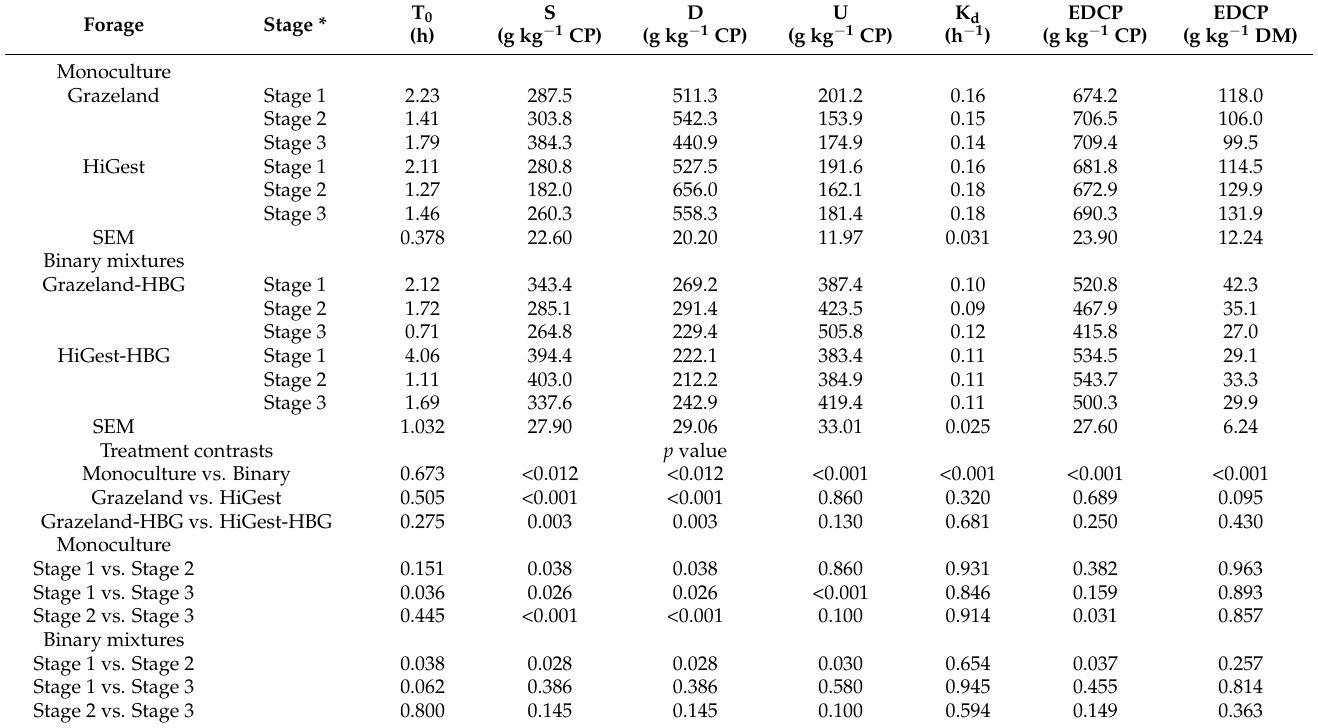
Table 4. Effects of cultivar, maturity, and their interaction on in situ rumen degradation kinetics of CP of alfalfa cultivars in monoculture and in binary mixtures with AC Success hybrid bromegrass (HBG) in Saskatoon, Saskatchewan